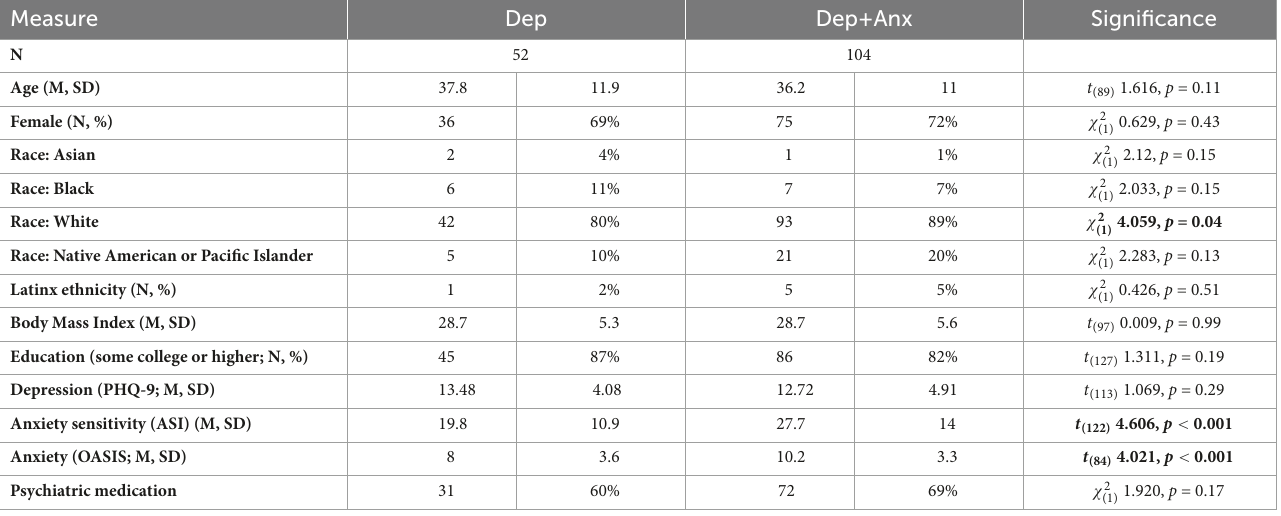
TABLE 1 Demographics of propensity matched Depressed (Dep) and depressed and anxious (Dep+Anx) participants. Measure